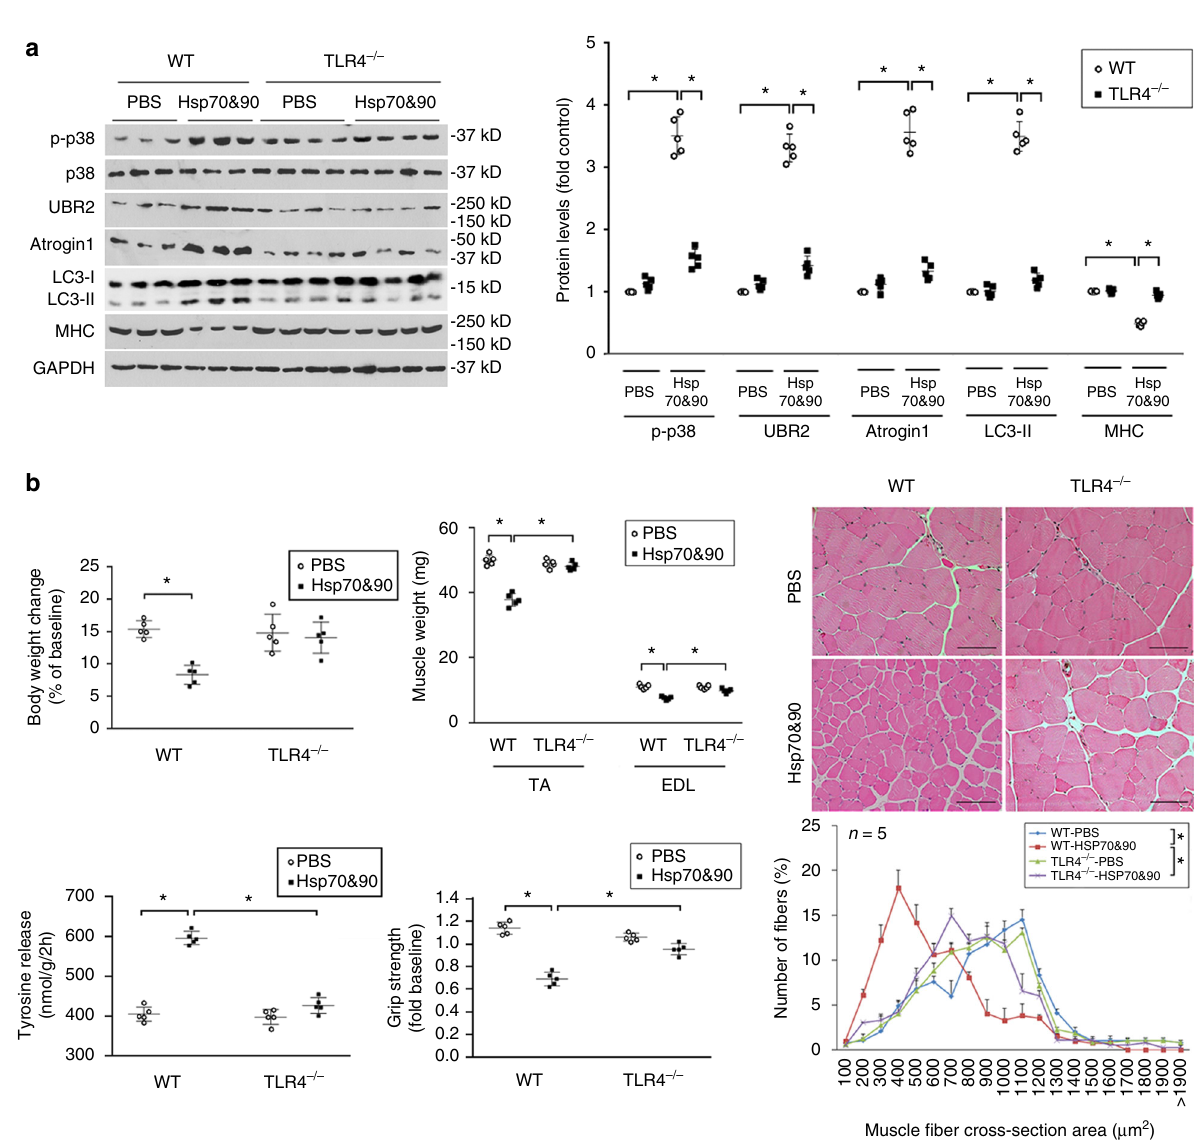
Fig. 9 TLR4 is critical to Hsp70/Hsp90-induced muscle wasting in mice. a Hsp70 and Hsp90-induced muscle catabolism in mice is dependent on TLR4. Wild-type and TLR4 null mice were injected with rHsp70 and rHsp90 and analyzed for catabolic response in TA as described in Fig. 4. b Hsp70 and Hsp90-induced muscle wasting is TLR4-dependent. Wild-type and TLR4 null mice injected with rHsp70 and rHsp90 are further analyzed for muscle wasting. Scale bar , 100 μ m. Data ( n = 5) were analyzed by analysis of variance or χ 2 analysis (for CSA). * denotes a difference ( P < Baculovirus expression vector (Invitrogen), and expressed in Sf9 insect cells by the Vector Core at Baylor College of Medicine in Houston and puri fi ed with Ni-NTA agarose (Invitrogen).